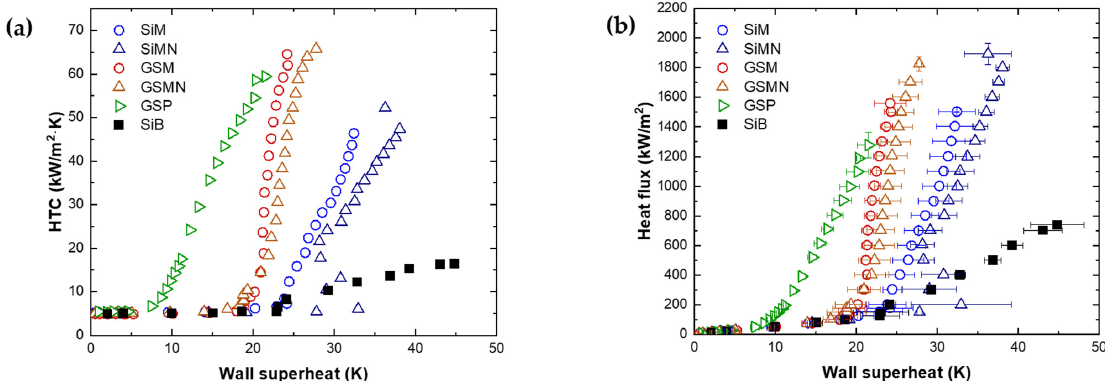
Figure 8. Pool boiling experimental data to confirm micro, micro/nanotextured surface with hydrophobic pattern effect. ( a ) Boiling heat transfer, ( b ) boiling curve.